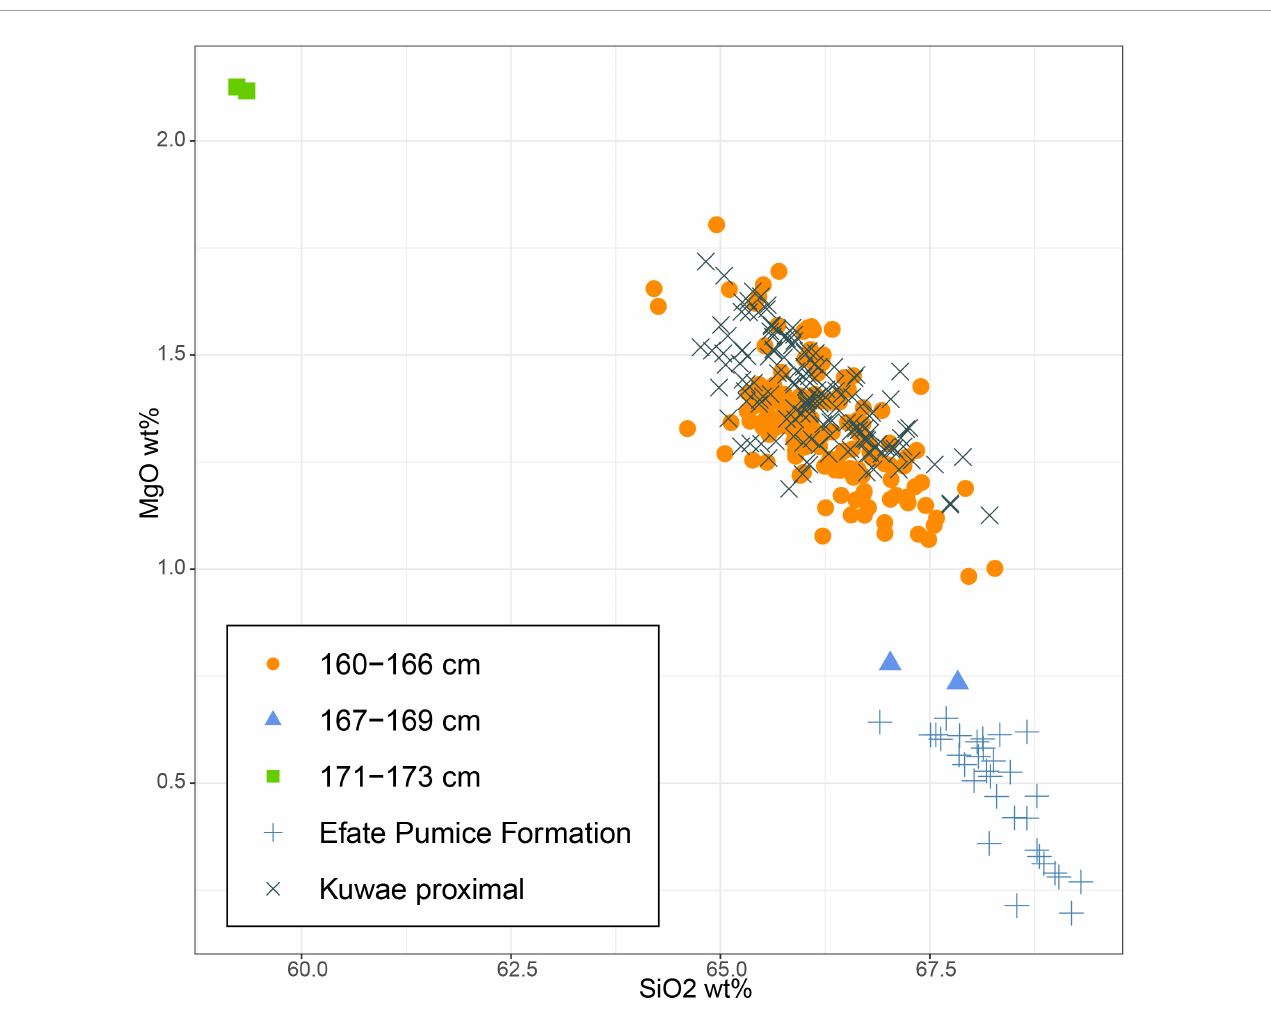
FIGURE2 Major element composition of the volcanic glass identified between depth compared to known sources where possible.